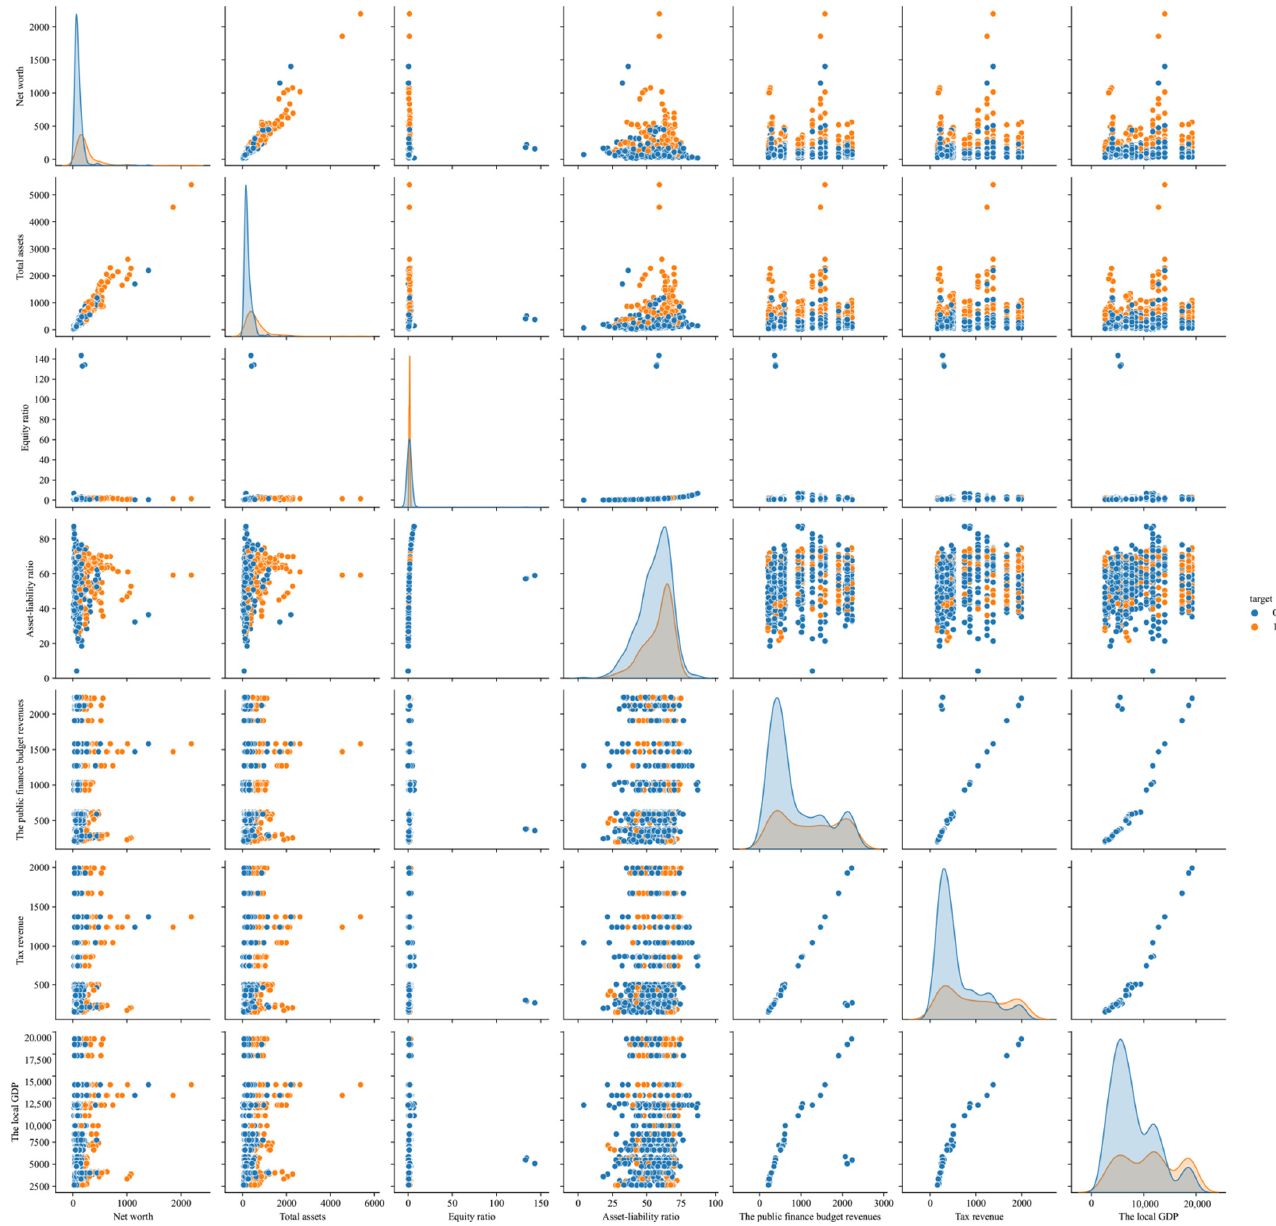
Figure 2. Multivariate joint distribution.